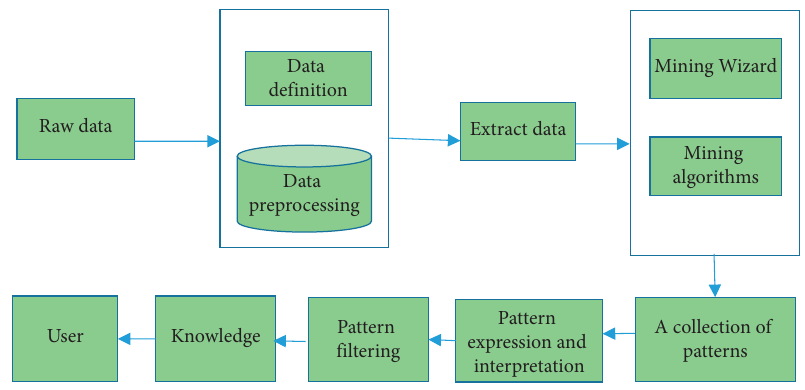
Figure 1: Data mining